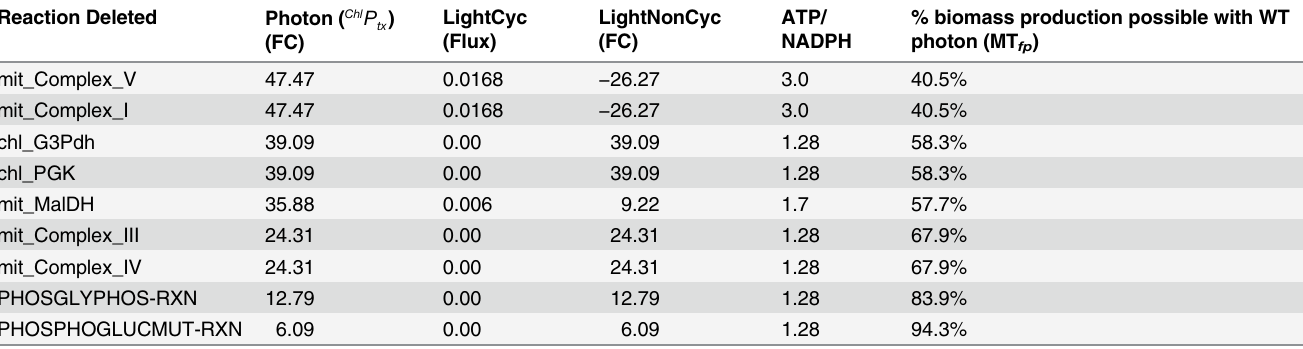
Table 2. Fold Change (FC) in photon flux while some of the maximally-favourable reactions (1 − I U * 0) are deleted. ‘ chl_ ’ and ‘ mit_ ’ represent the chloroplastic and mitochondrial reactions, respectively. From top to bottom the reactions are mitochondrial complex V, I, chloroplastic glyceraldehyde 3-phos- phate dehydrogenase, phosphoglycerate kinase, mitochondrial malate dehydrogenase, complex III, IV, cytosolic phosphoglycerate kinase and phosphoglu- comutase. While in case of LightNonCyc reaction, the increase or decrease in fold change is presented; since light cyclic (LightCyc) is not utilized in WT; only the values of fluxes are presented here.